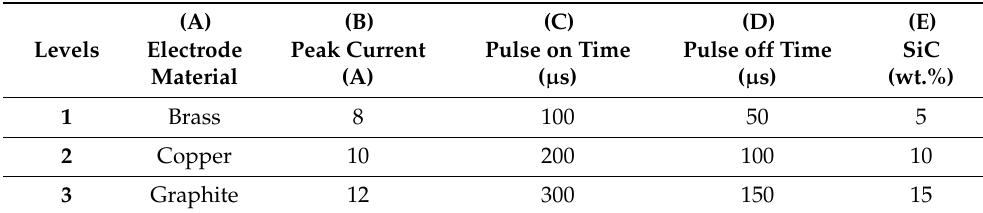
Figure 8. Electric dischargemachining set up. Table 5. Selected levels and factors